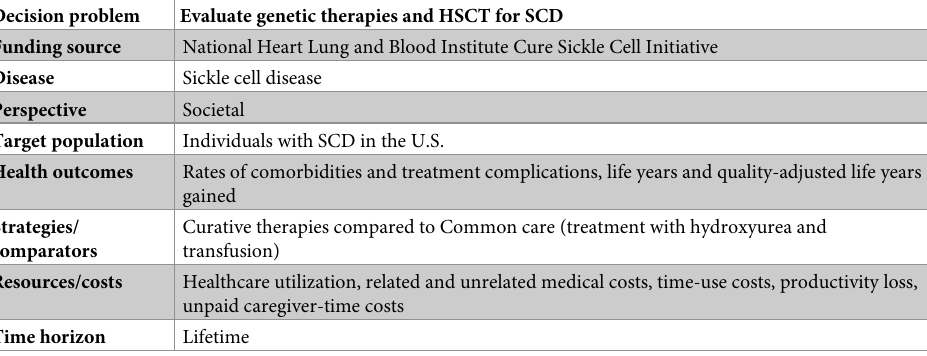
Table 1. Summary of model